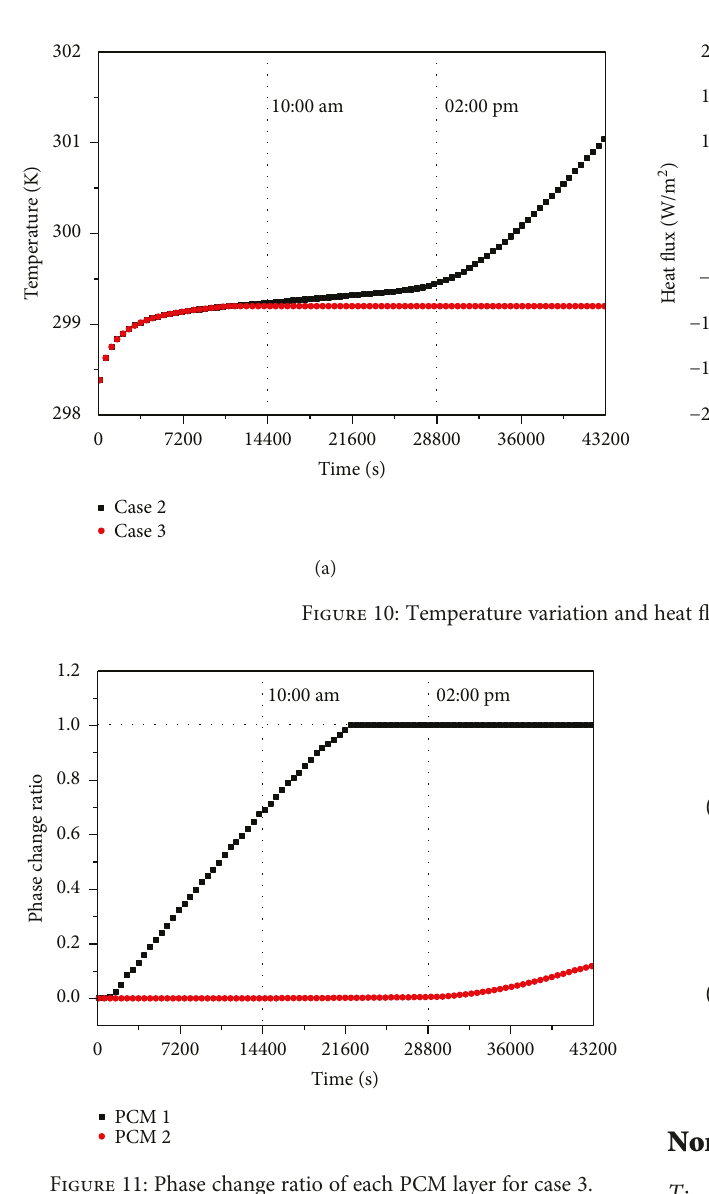
Figure 11: Phase change ratio of each PCM layer for case